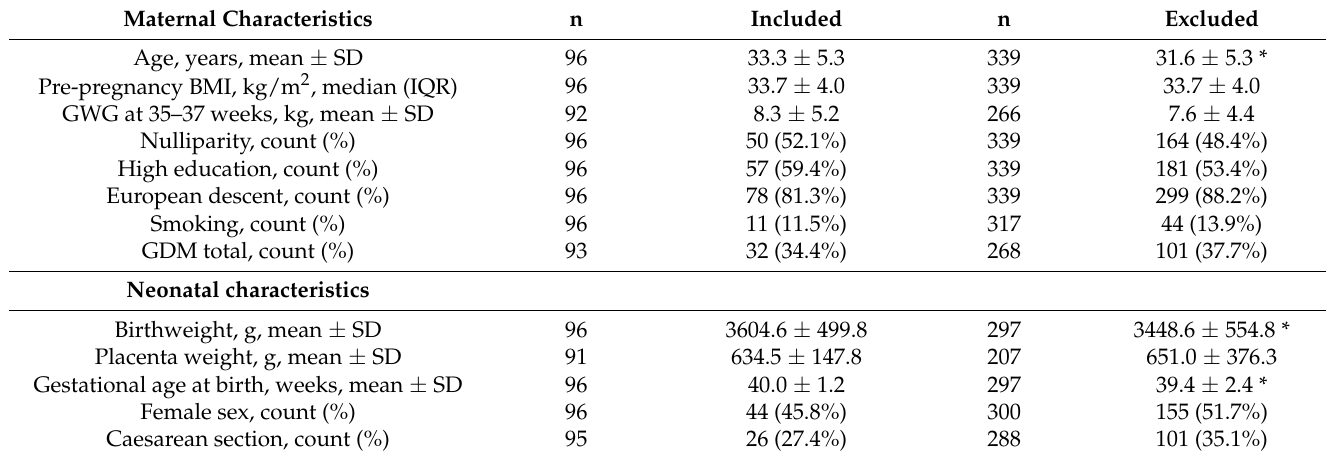
Table 1. Characteristics of study sample comparing included and excluded participants.